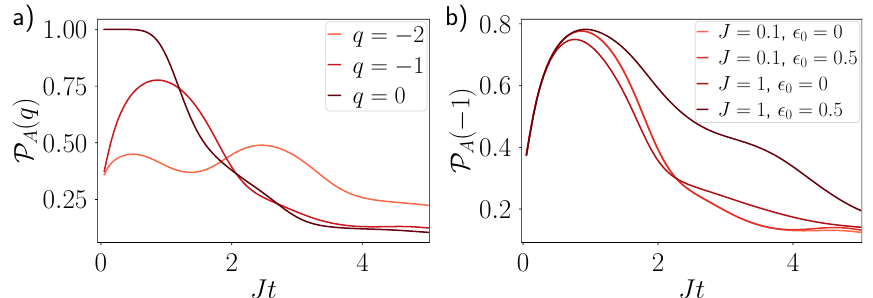
Figure 6: Symmetry-resolved purity for the Schwinger model in one